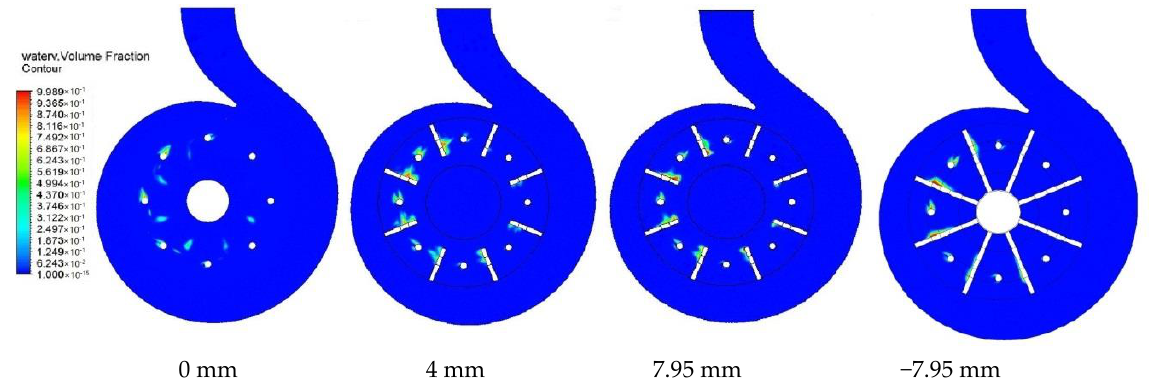
Figure 10. Cavitation distribution in the internal section of the impeller and volute of the blade disc pump (Q = 80.9 m 3 /h).